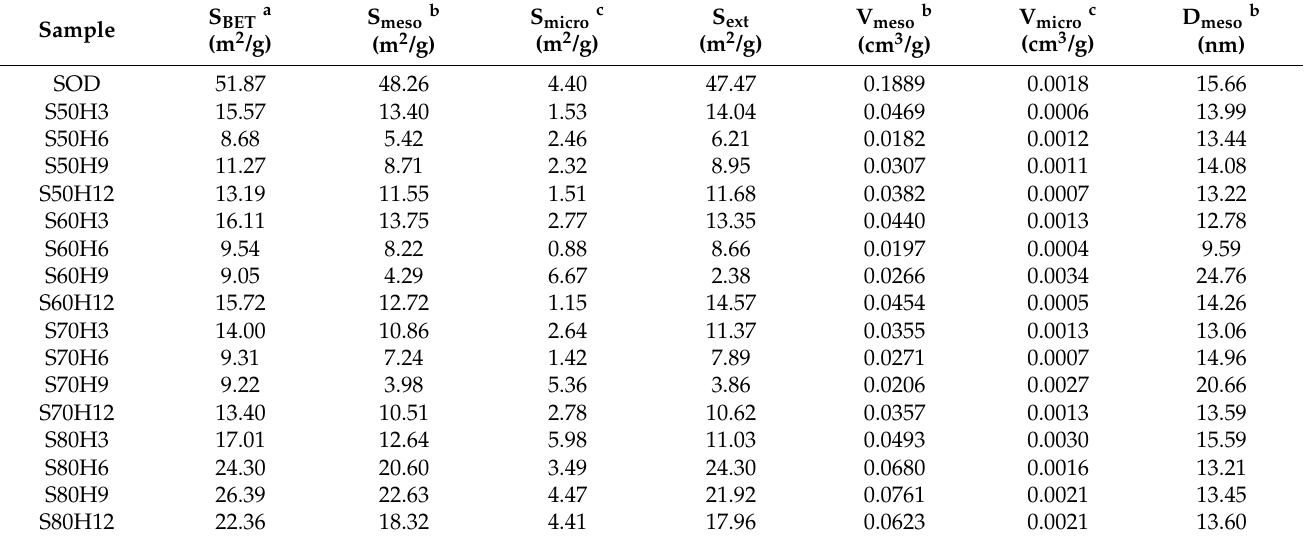
Table 4. Textural properties of